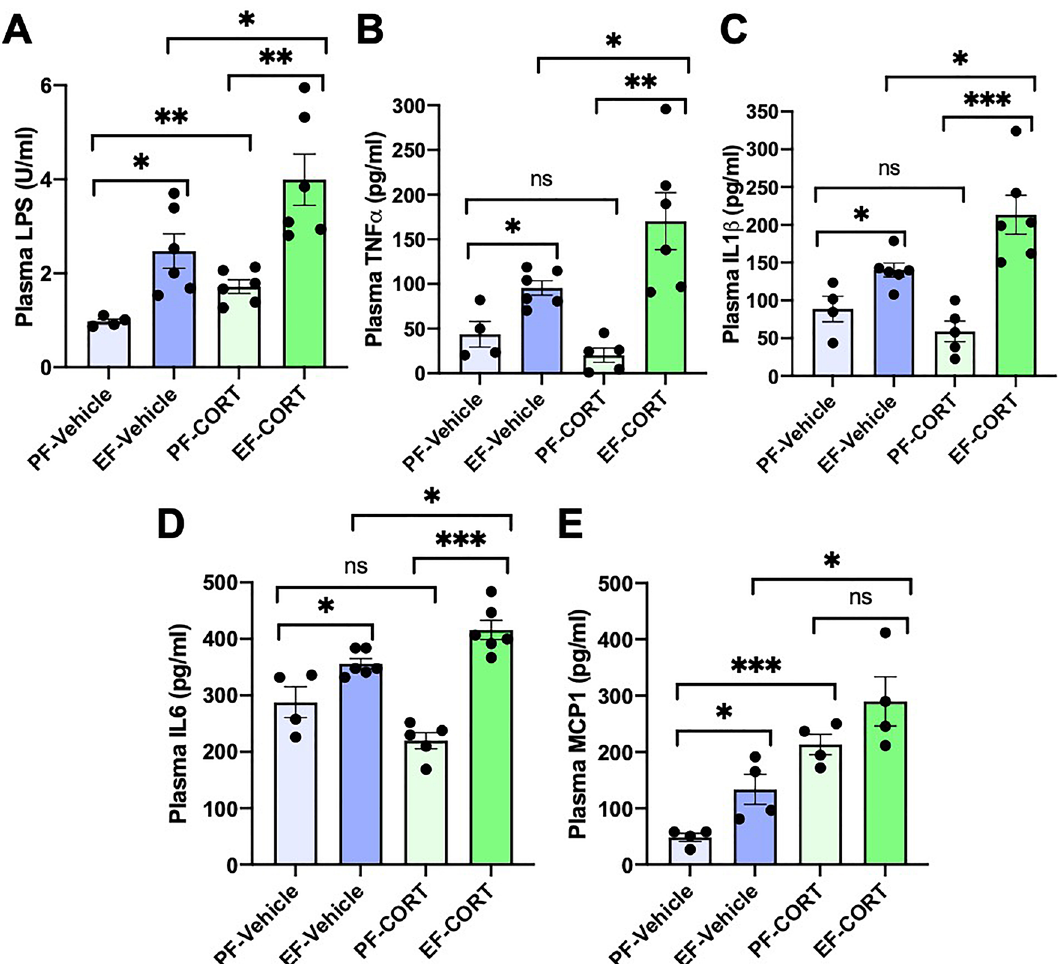
Figure 3. Corticosterone exacerbates alcohol-induced endotoxemia and systemic inflammation. Adult mice were fed a liquid diet with (EF) or without (PF) ethanol for four weeks. In some groups, animals were injected with corticosterone (CORT) daily. Animals in other groups were injected with the vehicle. ( A ) Endotoxemia was assessed by measuring plasma LPS levels. ( B – D ) Levels of TNFα ( B ), IL-1β ( C ), IL-6 ( D ), and MCP1 ( E ) were measured in plasma by ELISA. Values in graphs are mean ± SEM (n = 6, except 4 for the PF-Vehicle group). Dots in bars indicate individual values. The numbers above the bars are p -values for differences between the groups indicated by the horizontal lines, and "ns" indicates no significant difference between